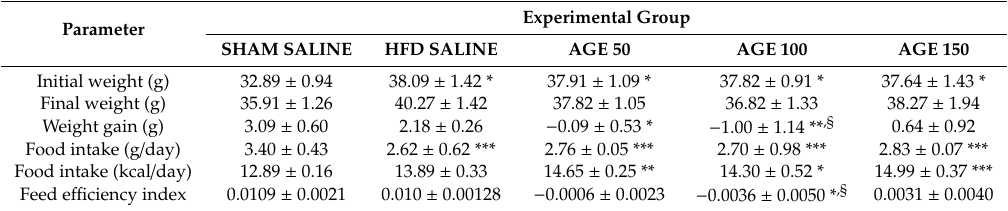
Table 3. Initial and final weight, weight gain, and food intake of control animals and animals treated with AGE between the 13th and the 24th